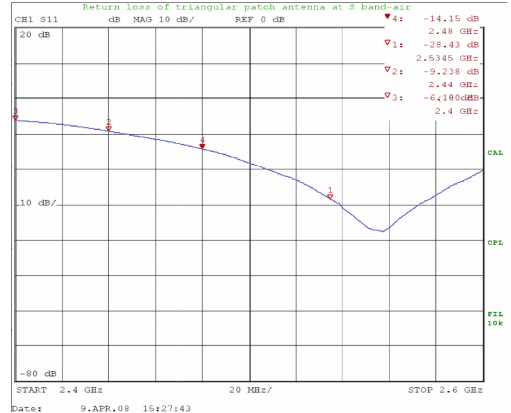
Figure 10: Measured retun loss using air gap.